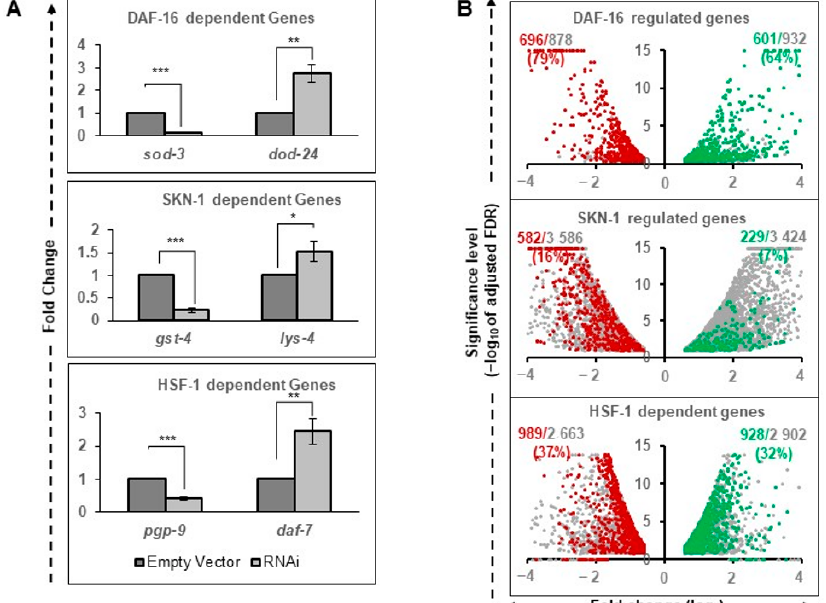
Figure A4. Quantification of rIIS-dependent targets and relative fraction of TF-dependent genes. ( A ) Quantitative real-time PCR of DAF-16 (upper panel), SKN-1 (middle panel), and HSF-1 (lower panel) well-known targets. One target each from the genes activated and repressed by the respective TF has been quantified in the rrf-3(pk1426);daf-2 (e1368) double mutants. ( B ) Volcano plots between log 10 of adjusted FDR significance level and log 2 fold change of TF-dependent genes (gray color dots). The fraction of these genes specific to the rIIS condition is represented by green and red coloring. Genes regulated by TFs and specific to rIIS condition are shown in percentage. The p -values were represented with * ≤ 0.05, ** ≤ 0.01 and *** ≤ 0.001.